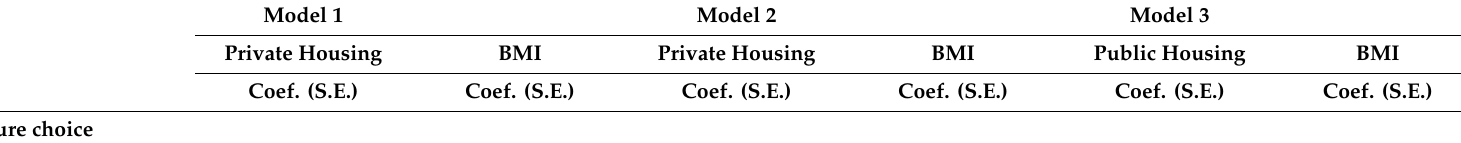
Table 4. Results of structural equation